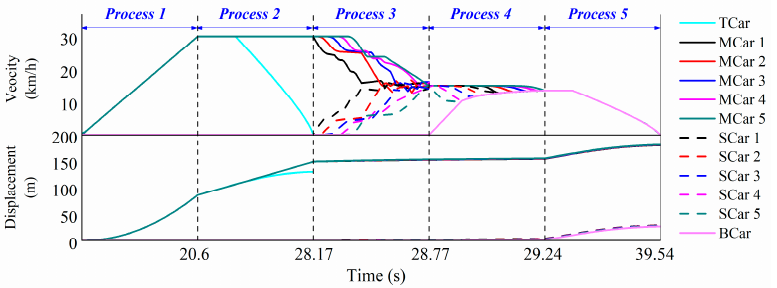
Figure 7. Dynamic response of each vehicle during the whole process of vehicle collision based on dynamic simulation result. 3. Test